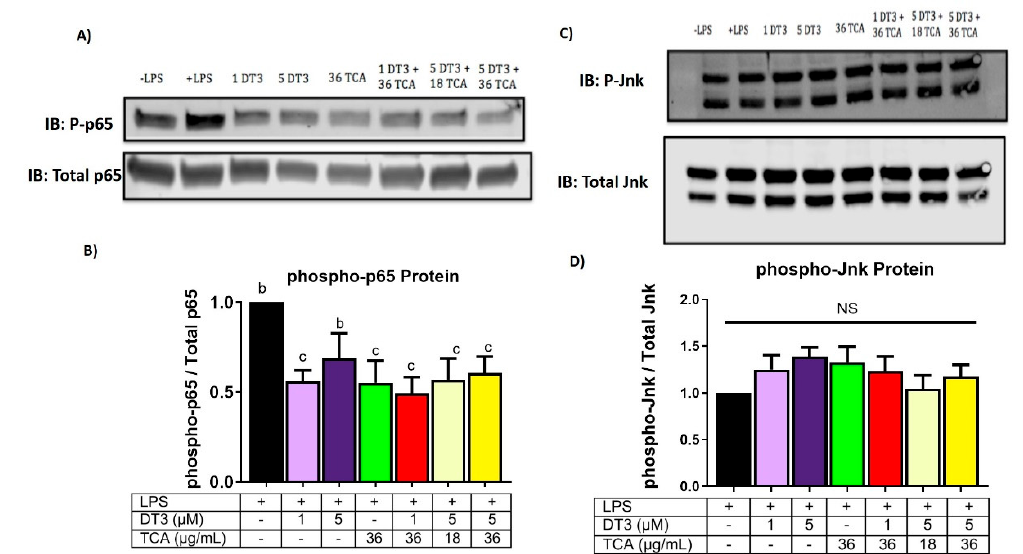
Figure 8. Delta-tocotrienol and tart cherry anthocyanin reduced protein expression of p65 in NFkB pathway. ( A , B ) DT3 and TCA significantly reduced p65 expression in all but the 5 µ M dT3 treatment group, compared to the LPS control means with di ff erent letters (b, c) are significant. n = 10, p < 0.05. ( C , D ). DT3 and TCA showed no reduction in expression of JNK ( n = 10).